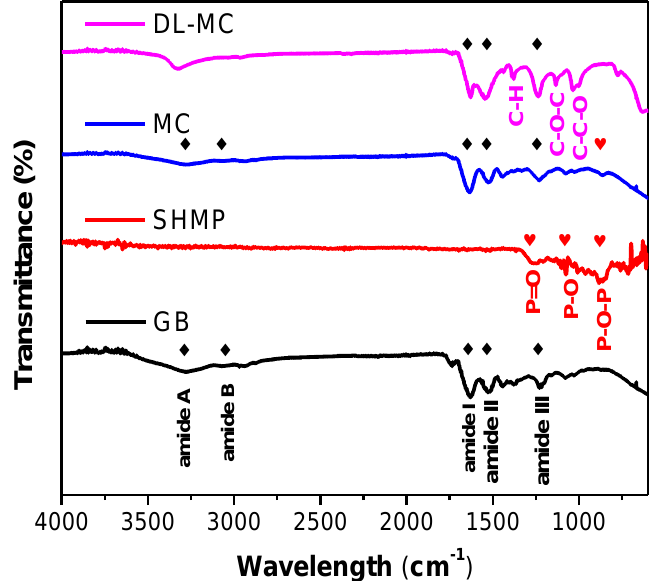
Figure 5. FTIR spectra of microcapsules and microcapsule components ( ◆ : GB, ♥ : SHMP).